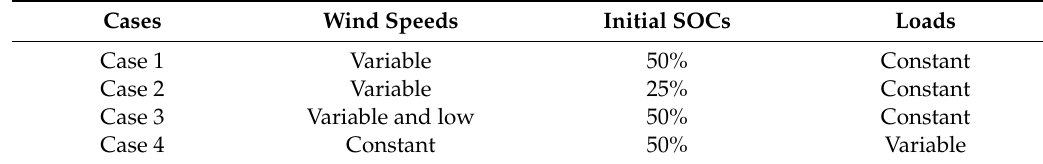
Table 2. Organization of the case